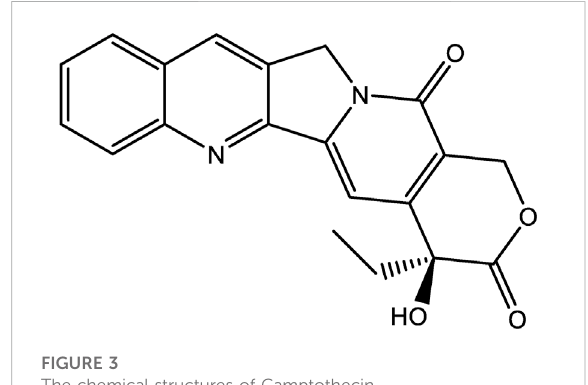
FIGURE 3 The chemical structures of